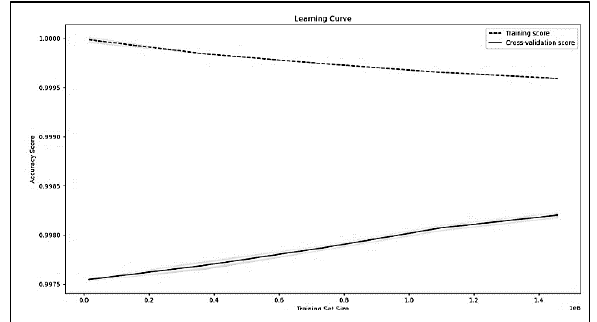
Figure 19: Random Forest Learning